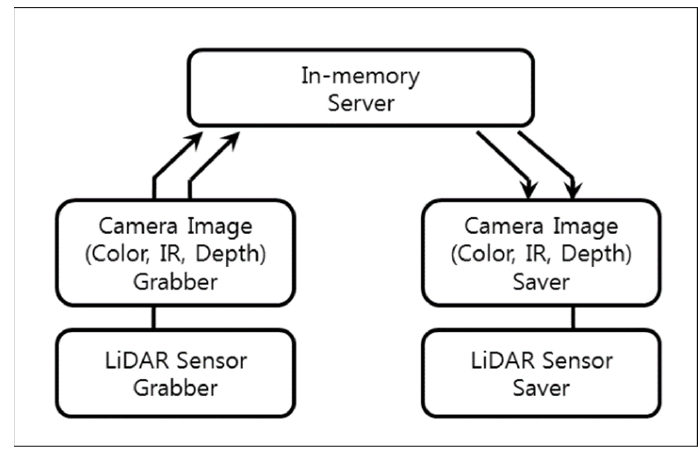
Figure 8. Data acquisition process for synchronization of multimodal sensor data.